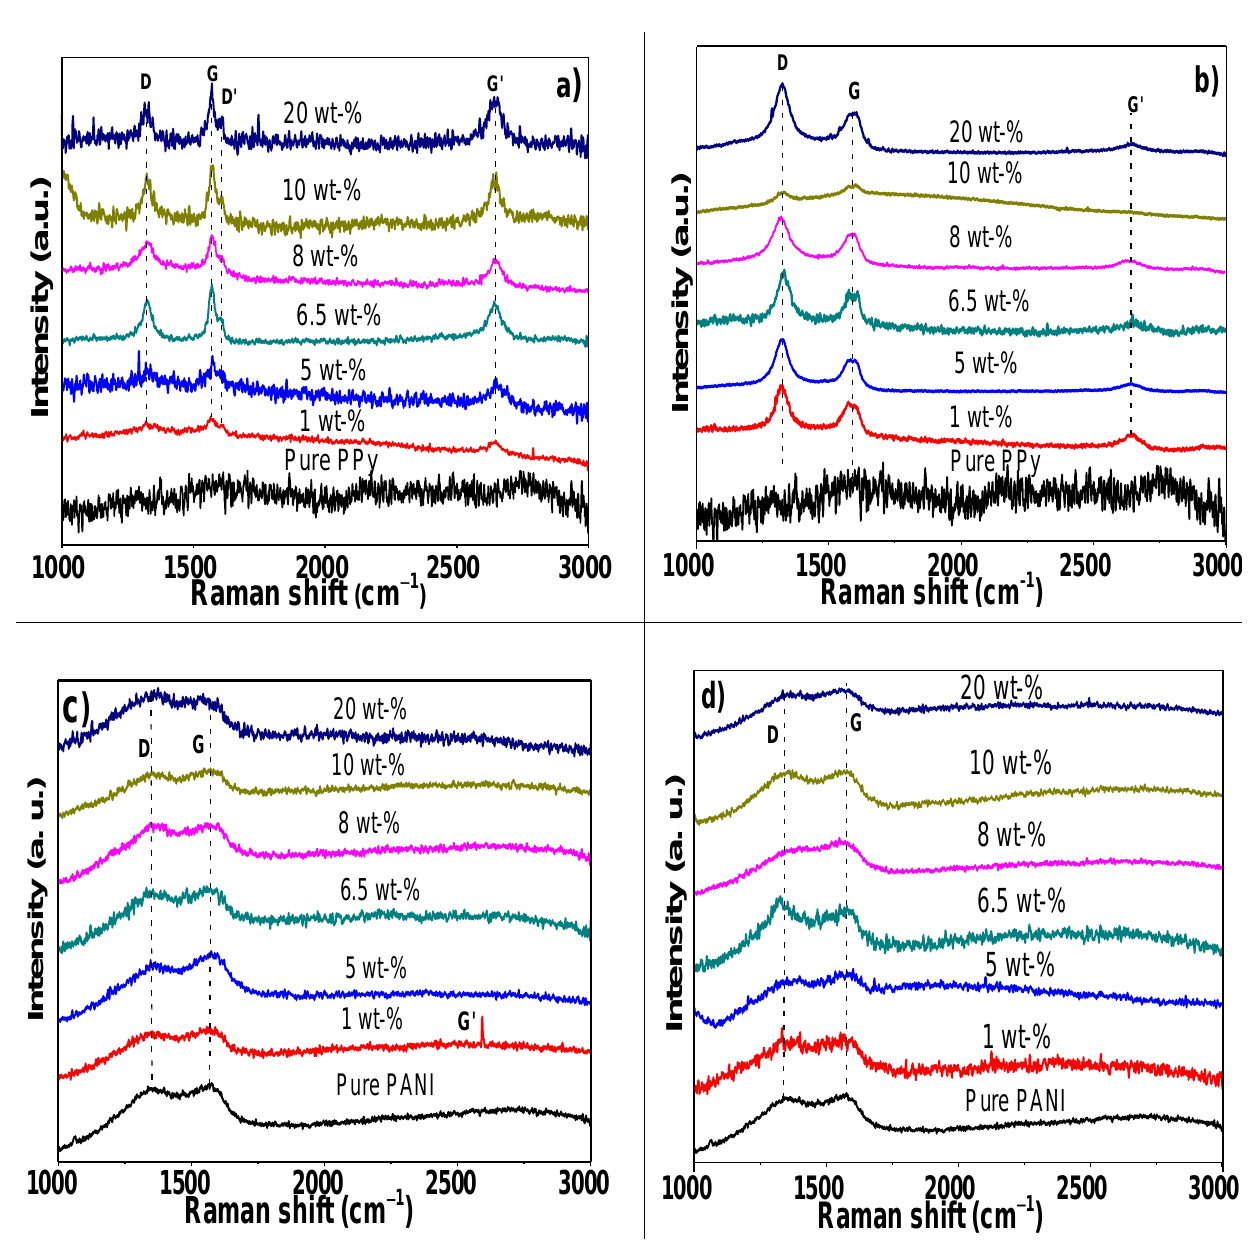
Figure 8. Raman of electropolymerized composites of ( a ) PPy/synthesized CNTs, ( b ) PPy/commercial MWCNTs nanocomposites, ( c ) PANI/synthesized MWCNTs, and ( d ) PANI/commercial MWCNTs. The Raman spectra of the electropolymerized PPy composites with different compositions of MWCNTs synthesized at 1123 K and purified with HCl + H 2 O 2 are shown in Figure 8a. A comparison of PPy/MWCNTs composites under similar synthesis conditions is presented in Figure 8b.